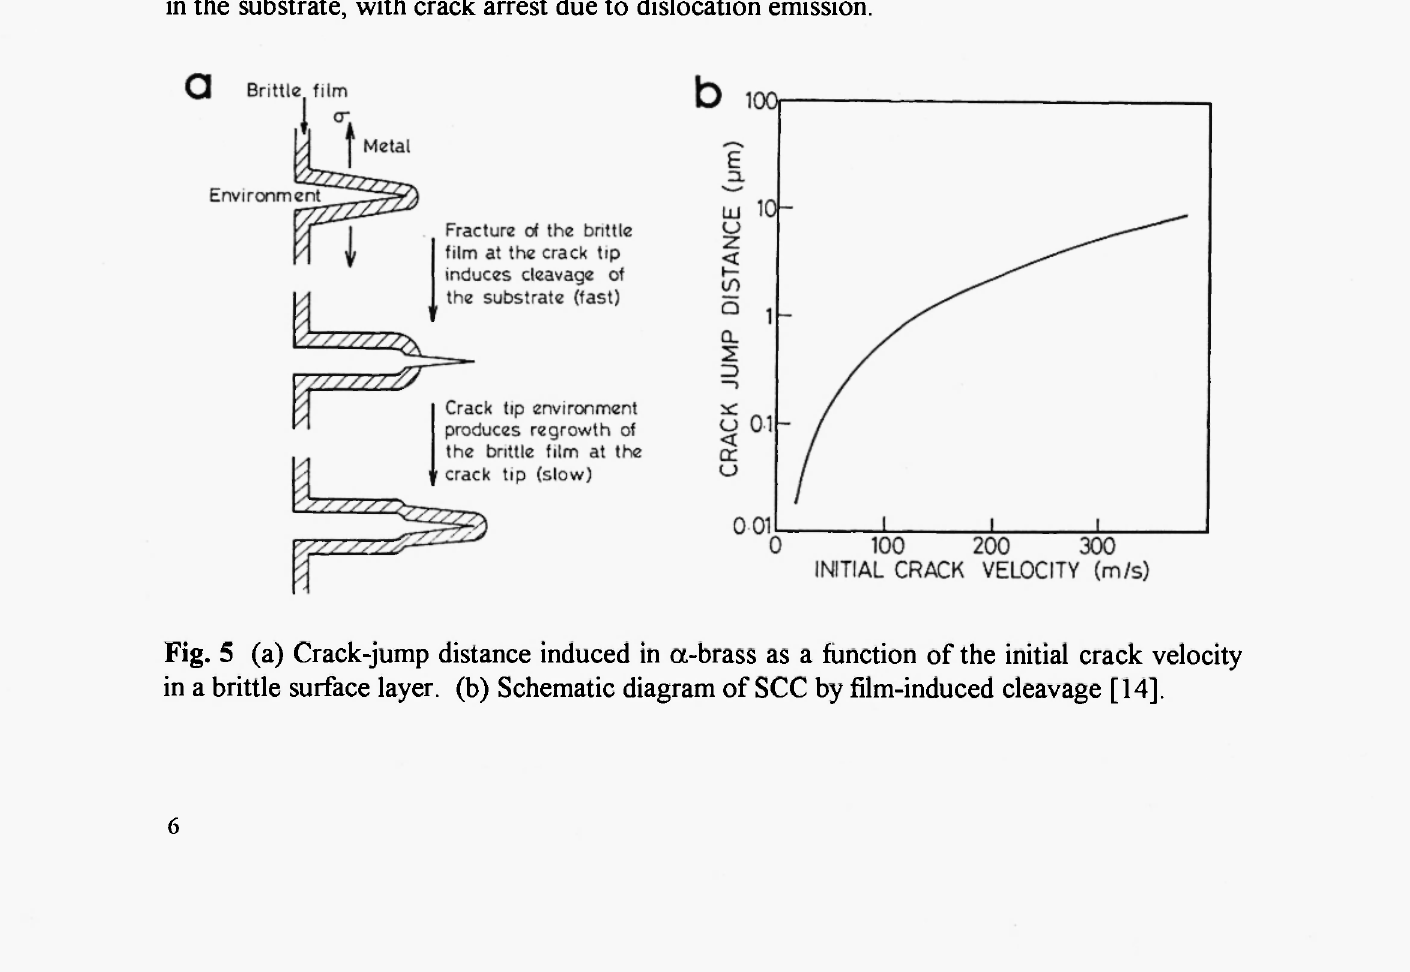
Fig. 5 (a) Crack-jump distance induced in α-brass as a function of the initial crack velocity in a brittle surface layer, (b) Schematic diagram of SCC by film-induced cleavage